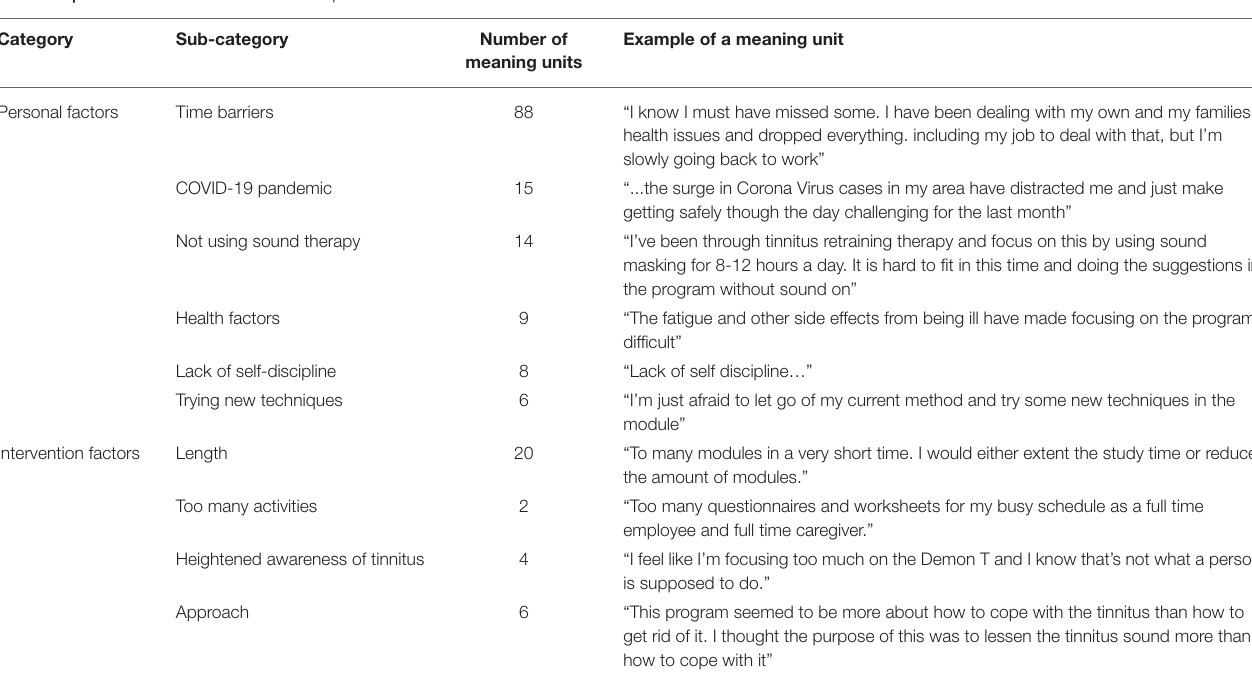
TABLE 6 | The barriers to the intervention